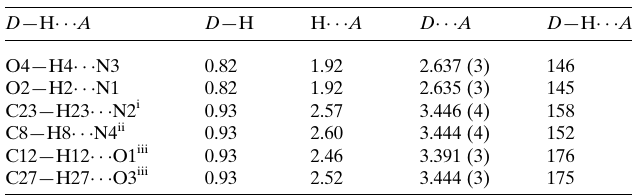
Table 1 Hydrogen-bond geometry (A˚ , (cid:2) ).